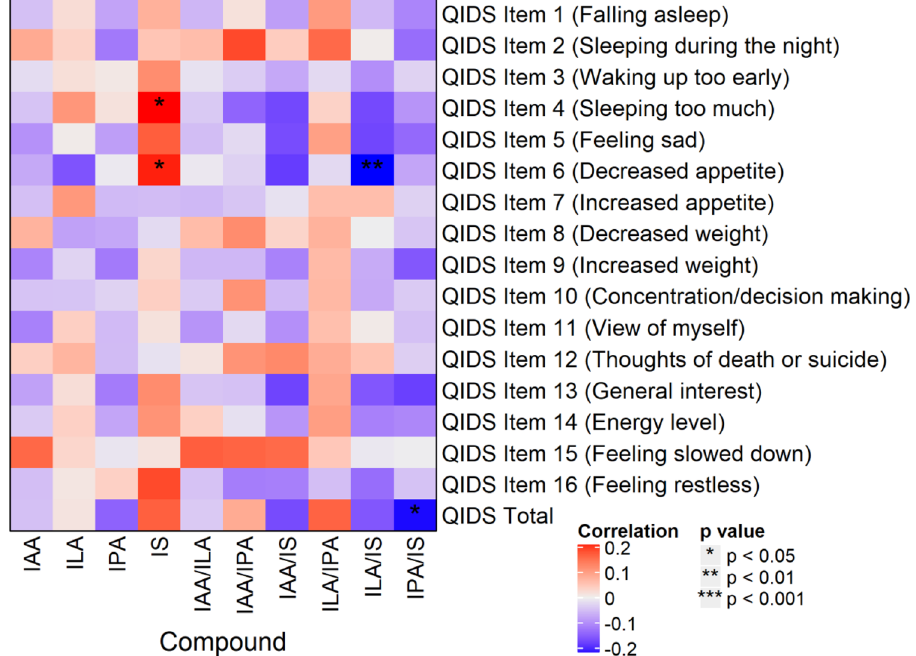
Figure 3. Heat map of Holm-corrected partial Spearman rank correlations between baseline indole abundance/ ratio and QIDS-SR items and total score, after accounting for age, sex, and BMI. QIDS-SR 16-item Quick Inventory of Depressive